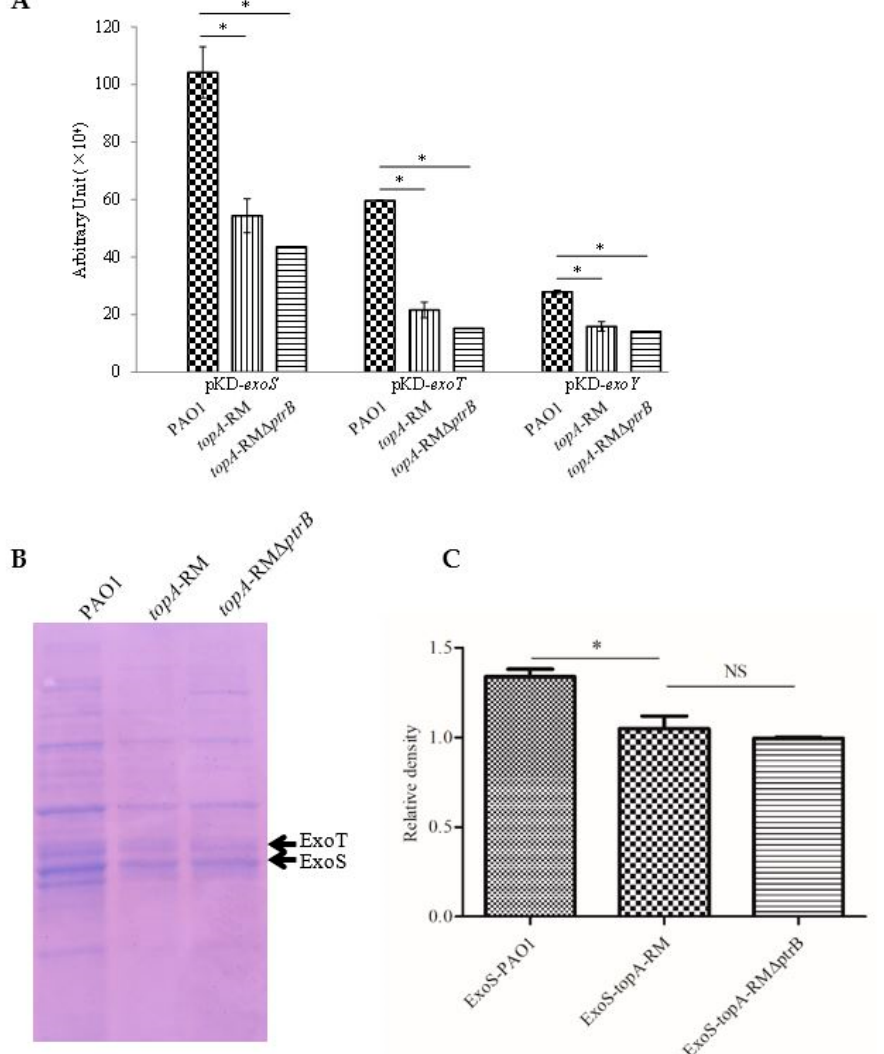
Figure 9. Comparison of T3SS genes expression and effectors production in PAO1, topA -RM and topA -RM ∆ ptrB . ( A ) T3SS effector genes expression in PAO1, topA -RM and topA -RM ∆ ptrB . The T3SS reporter strain cultures were serial diluted and spotted onto the LB plate. After overnight incubation at 37 ◦ C, light production of the reporter strain was recorded by a LAS-3000 imaging system (Fuji Corp.). The relative quantification was evaluated by the software multi gauge version 3.0. ( B ) Secreted protein levels of T3SS effectors in PAO1, topA -RM and topA -RM ∆ ptrB . ( C ) Quatification of the ExoS production in PAO1, topA -RM and topA -RM ∆ ptrB . The proteins in the supernatant of different strain cultures were precipitated by TCA and analyzed by SDS-PAGE, followed by staining with Coomassie blue. ExoT (upper) and ExoS (lower) are indicated by solid arrows as established in previous reports [28,31]. The two–tailed unpaired t -test was used to analyze the data using the GraphPad software version 5.0 (*, P < 0.05). NS: No significant difference.